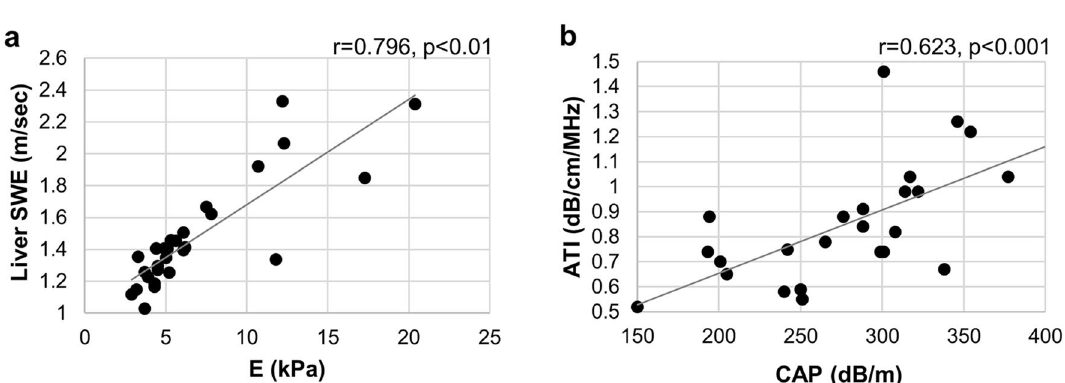
Figure 2. Correlation between the change in ( a ) liver stiffness obtained by 2D-SWE and by TE with Fibroscan, and in ( b ) liver steatosis by ATI and